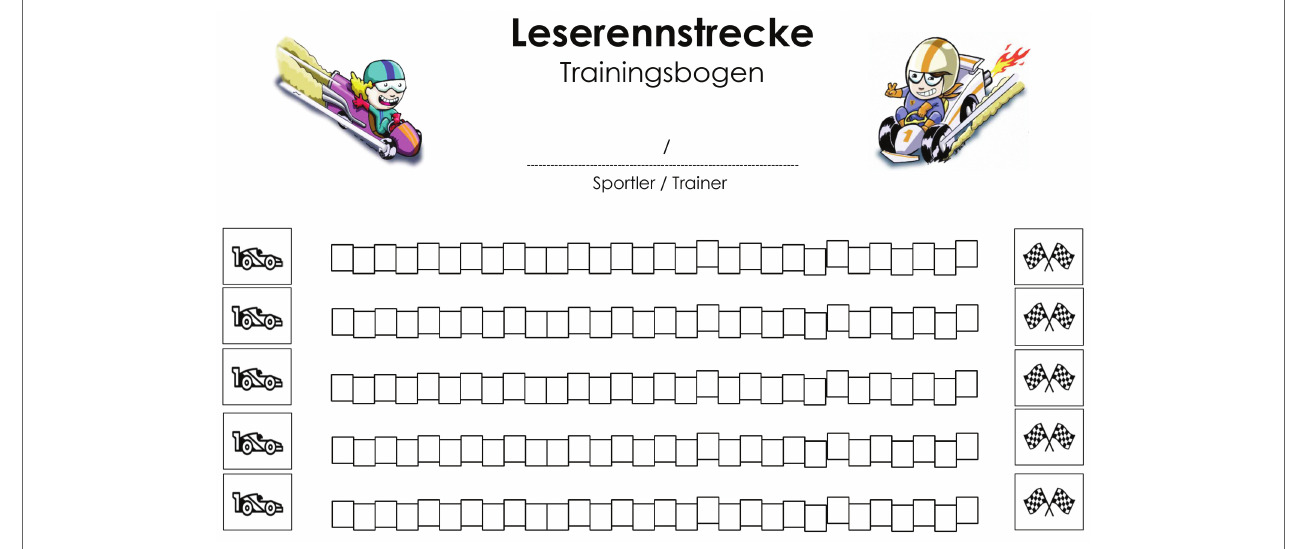
FIGURE 1 | Self-graphing sheet. Leserennstrecke, reading racetracks; Trainingsbogen, training sheet; Sportler,